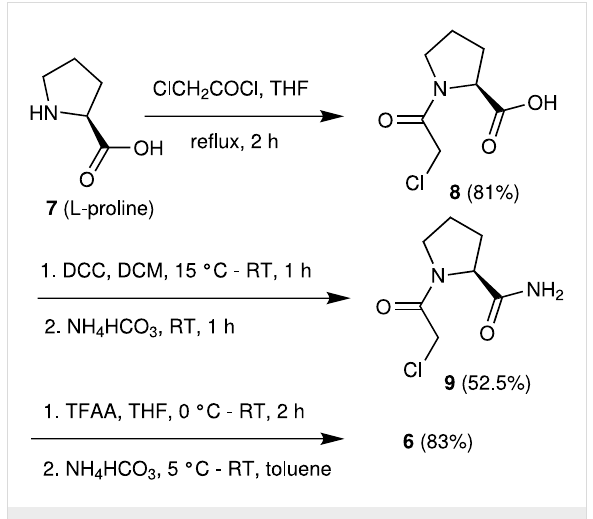
Scheme 2: Synthesis of ( S )-1-(2-chloroacetyl)pyrrolidine-2-carboni- trile ( 6